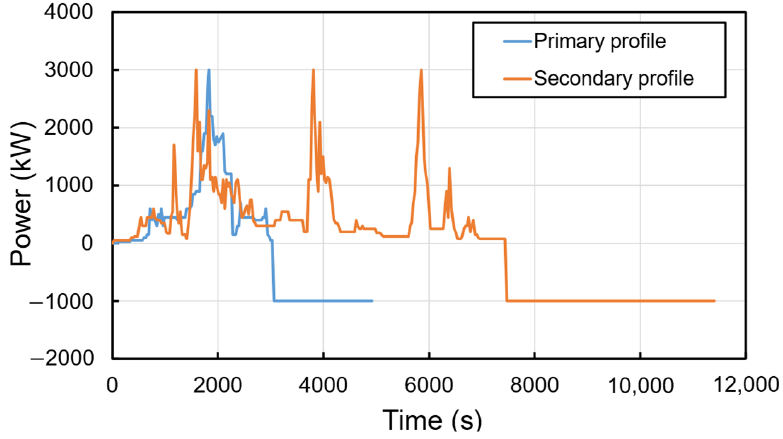
Figure 2. Primary and secondary load profiles of the full ‐ electric harbor tug.